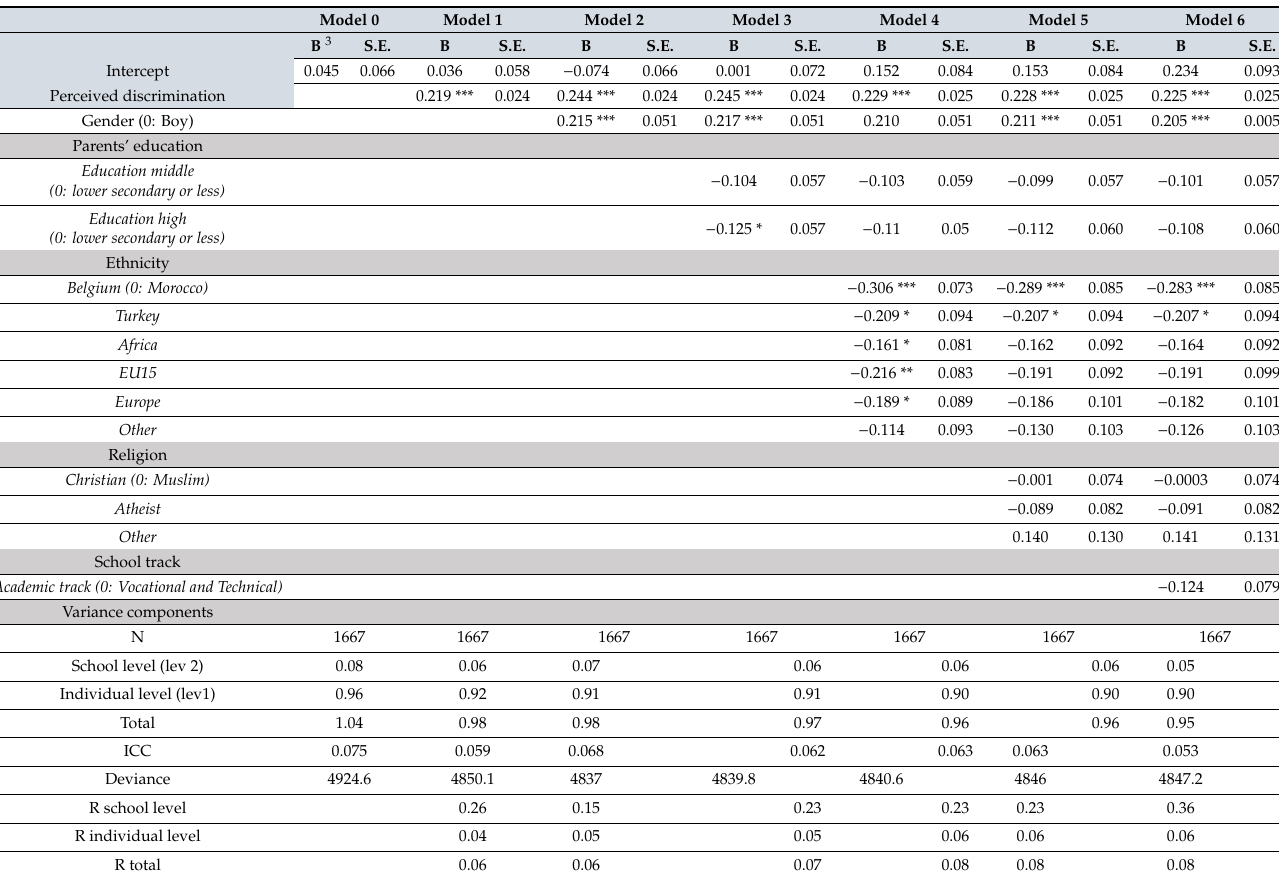
Table 6. Multilevel regression model concerning perceived discrimination and attitudes towards the rejection of representative democracy among 10th graders in